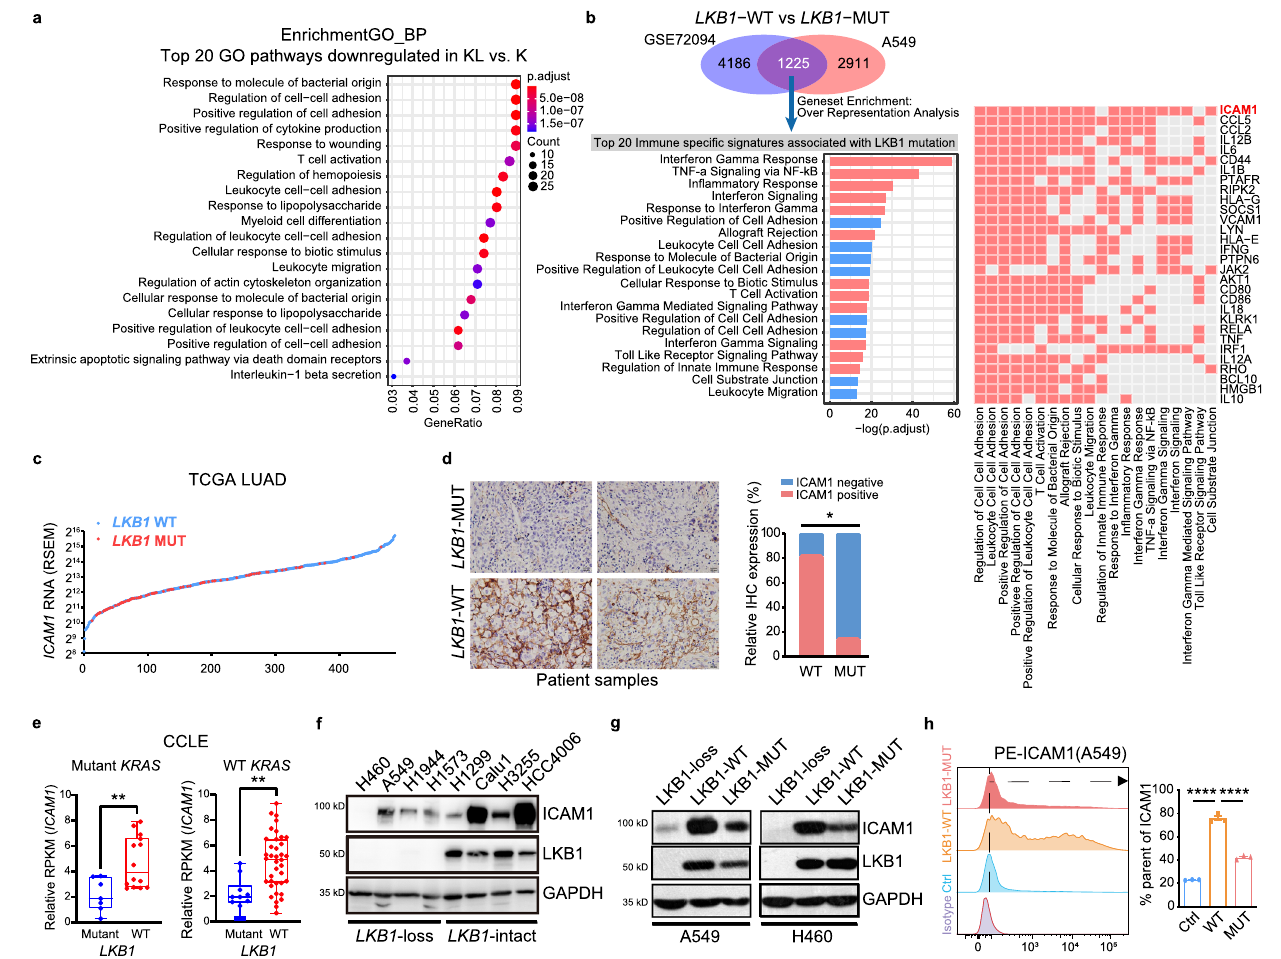
Fig. 2 | LKB1 regulates ICAM1 expression in non-small cell lung cancer. a Enrichment analysisonDEGs inthe cancercells between KL ( n =701 cells) versus K ( n =662 cells) using clusterPro fi ler for gene sets in GO terms. b Venn diagram showing the overlap of DEGs between LKB1 wild-type and mutated groups both in tissues(GSE72094, n =374for LKB1 -WT, n =68for LKB1 -MUT)andcells(A549cells, n =3for LKB1 -WT, n =3for LKB1 -MUT).Overrepresentationanalysiswasperformed using these overlap genes, and the top 20 immune-speci fi c signatures were revealed.Rankingofthegenesamongtheseenrichedsignaturesaccordingtotheir frequency. c Plot displays ICAM1 expression level in lung adenocarcinoma patient sampleswith( n =73)andwithout( n =437) LKB1 mutation. d Representativeimages and corresponding quanti fi cation of IHC staining of ICAM1 in human LUAD tumor sections in LKB1 wild-type and mutatedgroups. Scale bar, 50 μ m (40×). n =11 (WT) or n =7 (MUT) biologically independent samples examined over 1 independent experiment. ** p =0.0128. e Relative RPKM values of ICAM1 in LKB1 mutant versus LKB1 wild-type lung cancer cells from CCLE, with or without KRAS co-mutations.